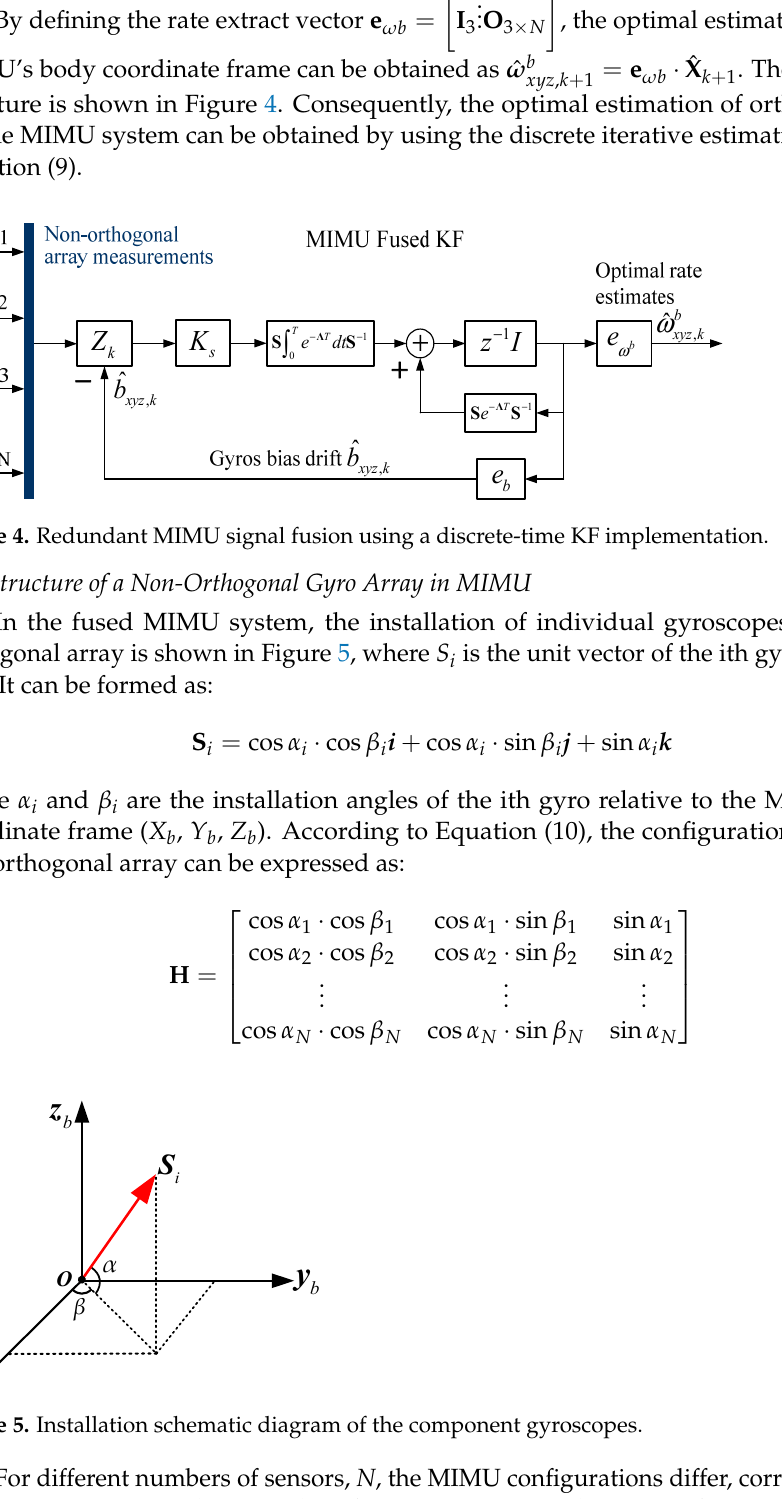
Figure 5. Installation schematic diagram of the component gyroscopes.